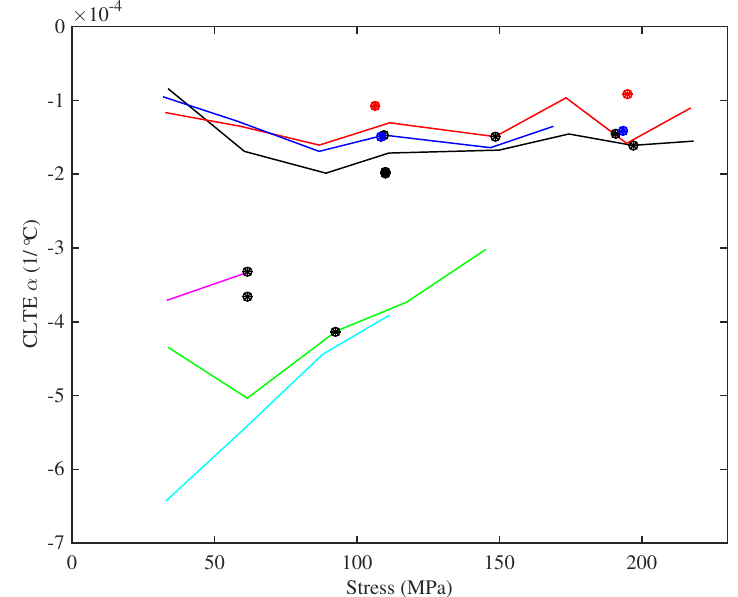
Figure 19. The coe ffi cient of linear thermal expansion (CLTE) along the strings, plotted against the applied stress. The CLTE values were derived from the thermal tension sensitivity, in the absence of any tuning adjustments, and the thermal variation in Young’s modulus. Colours identify the di ff erent tested strings (Table 1): black (8:A6), red (14:A5), blue (5:A4), green (23a:A3), cyan (29:E3), magenta (10b:A2). Black circles show the results at the expected operating points for the Bowbrand strings tested at the usual humidity levels (around 55–65% RH at 20 ◦ C); blue circles show Pirastro strings; red circles show tests at low humidity (around 20–26% RH at 20 ◦